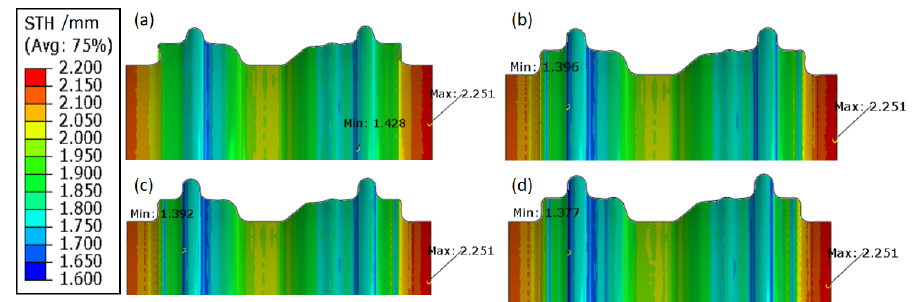
Figure 10. The thickness distribution at different steps: ( a ) after pre-hydroforming, ( b ) finish time of the movable bushes movement, ( c ) 100 MPa internal hydraulic pressure in the calibration step, and ( d ) 200 MPa internal hydraulic pressure in the calibration step.